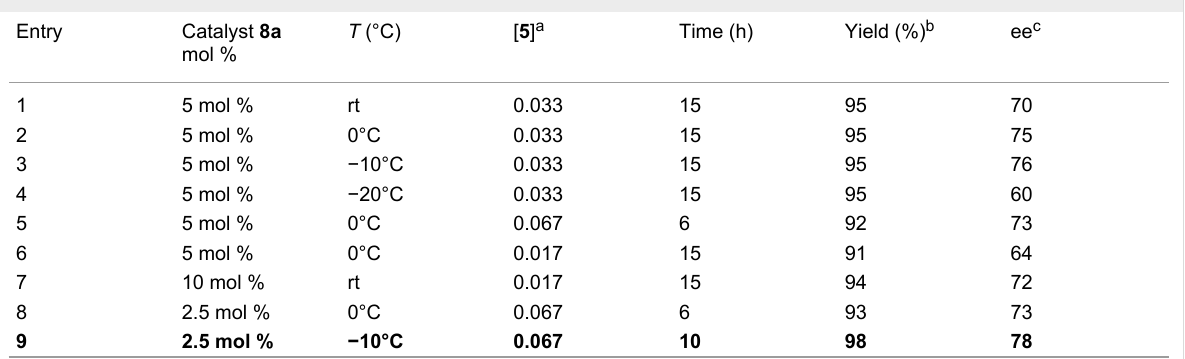
Table 2: Optimization of the asymmetric cascade